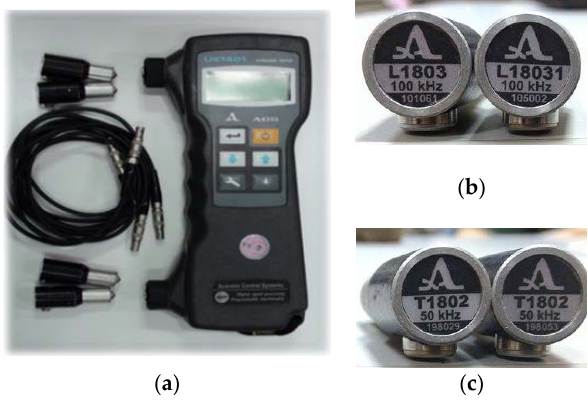
Figure 3. Dry point ultrasonic tester: ( a ) device; ( b ) pressure wave transducer of 100 kHz; ( c ) shear wave transducer of 50 kHz.